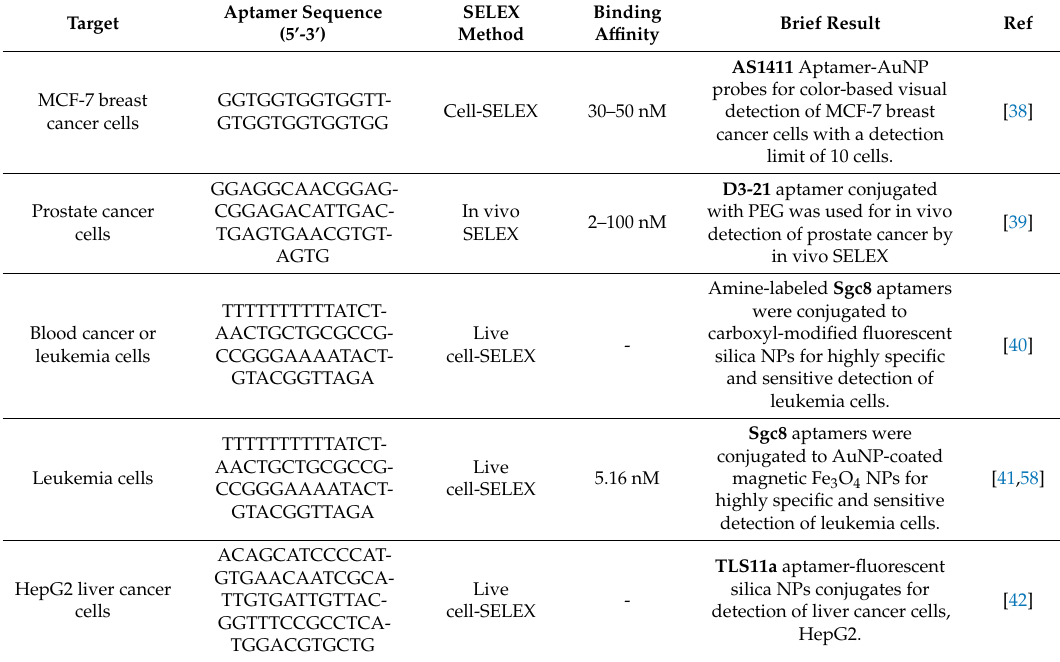
Table 1. A list of aptamers in the literature used for diagnosis of cancer cell lines through in vivo and in vitro SELEX.